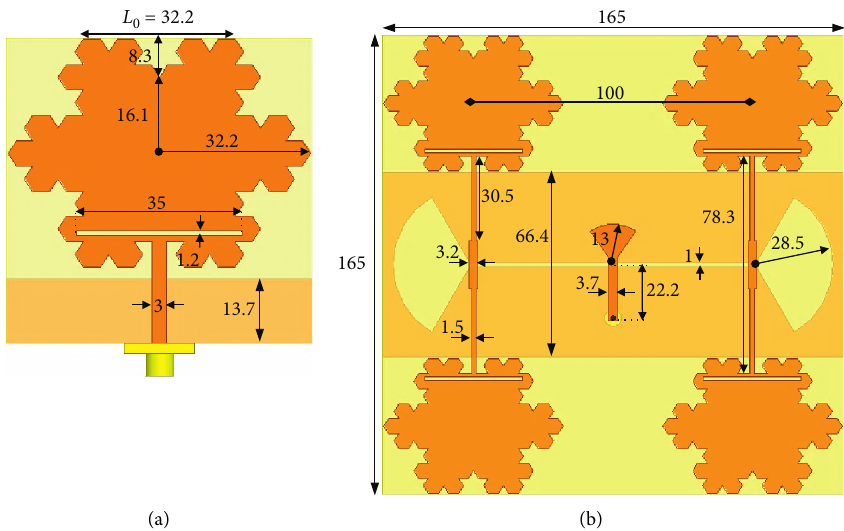
Figure 1: The layout and detailed dimensions of (a) single element and (b) the 2 × 2 monopole fractal antenna array (unit: mm).